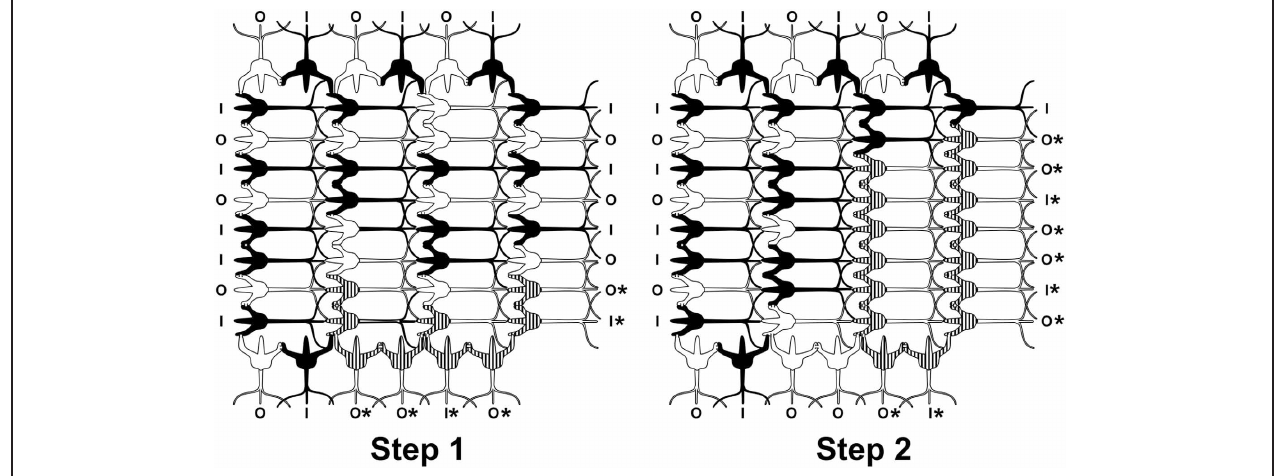
open and close, the synchronized web can move through the network, e.g., Step 1, 2. Mobile webs are candidates for the neural correlates of consciousness (NCC). Outputs marked by ∗ reflect collective integration and suggest conscious causal